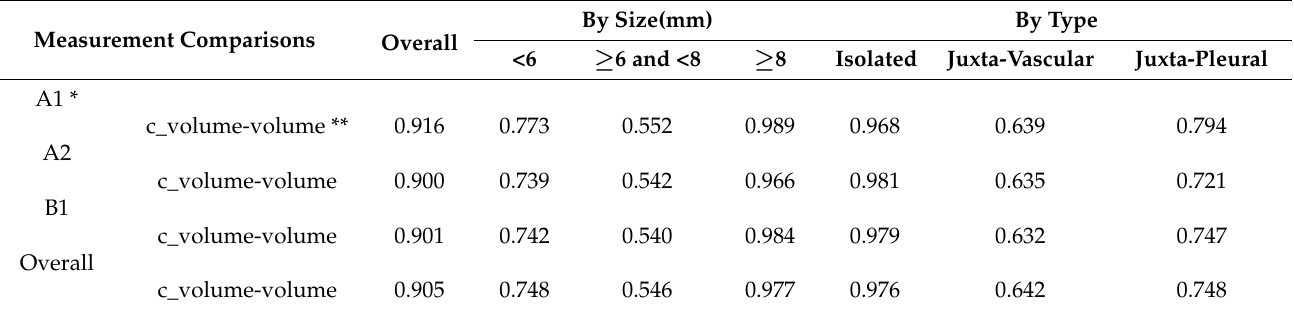
Table 2. ICCs of overall measurement by size, type, and reader.